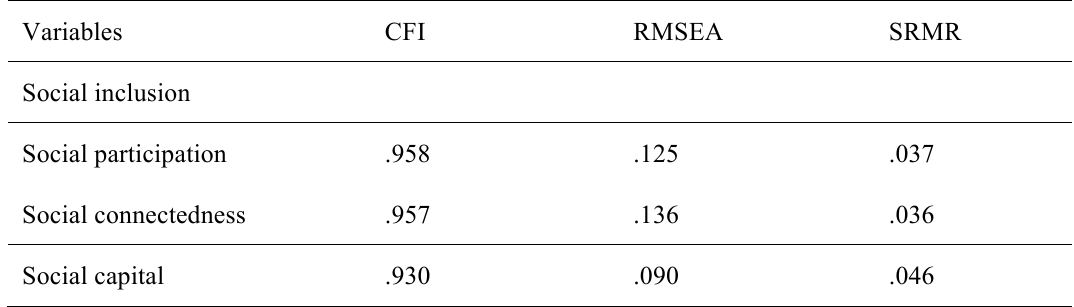
Table 3 : Results of confirmatory factor analysis.